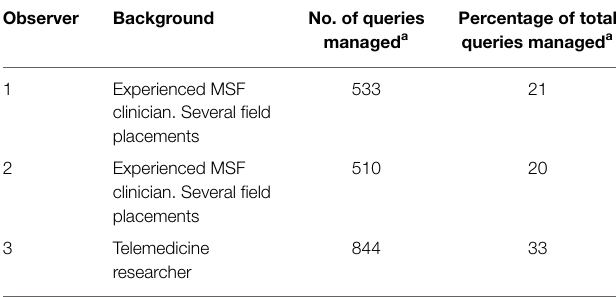
TABLE 2 | Details of the observers .